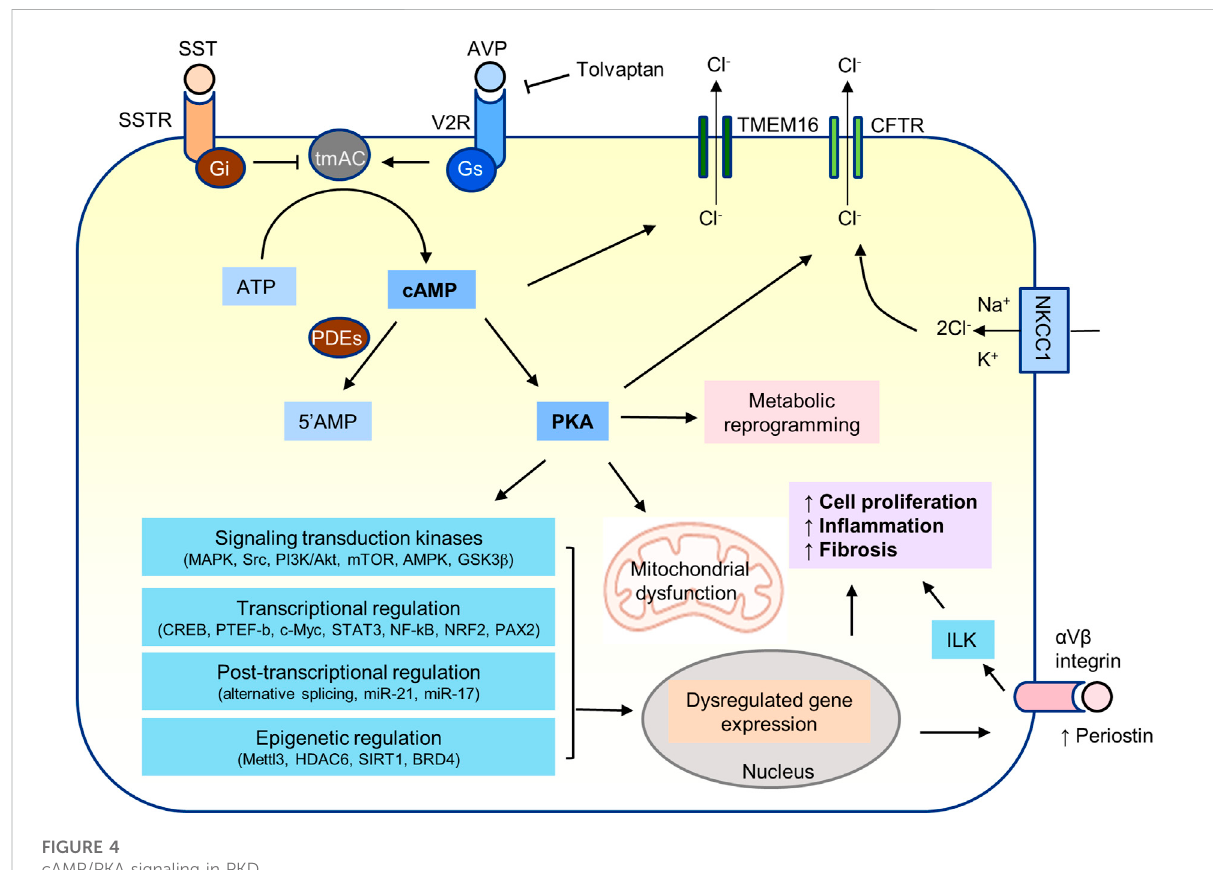
FIGURE 4 cAMP/PKA signaling in